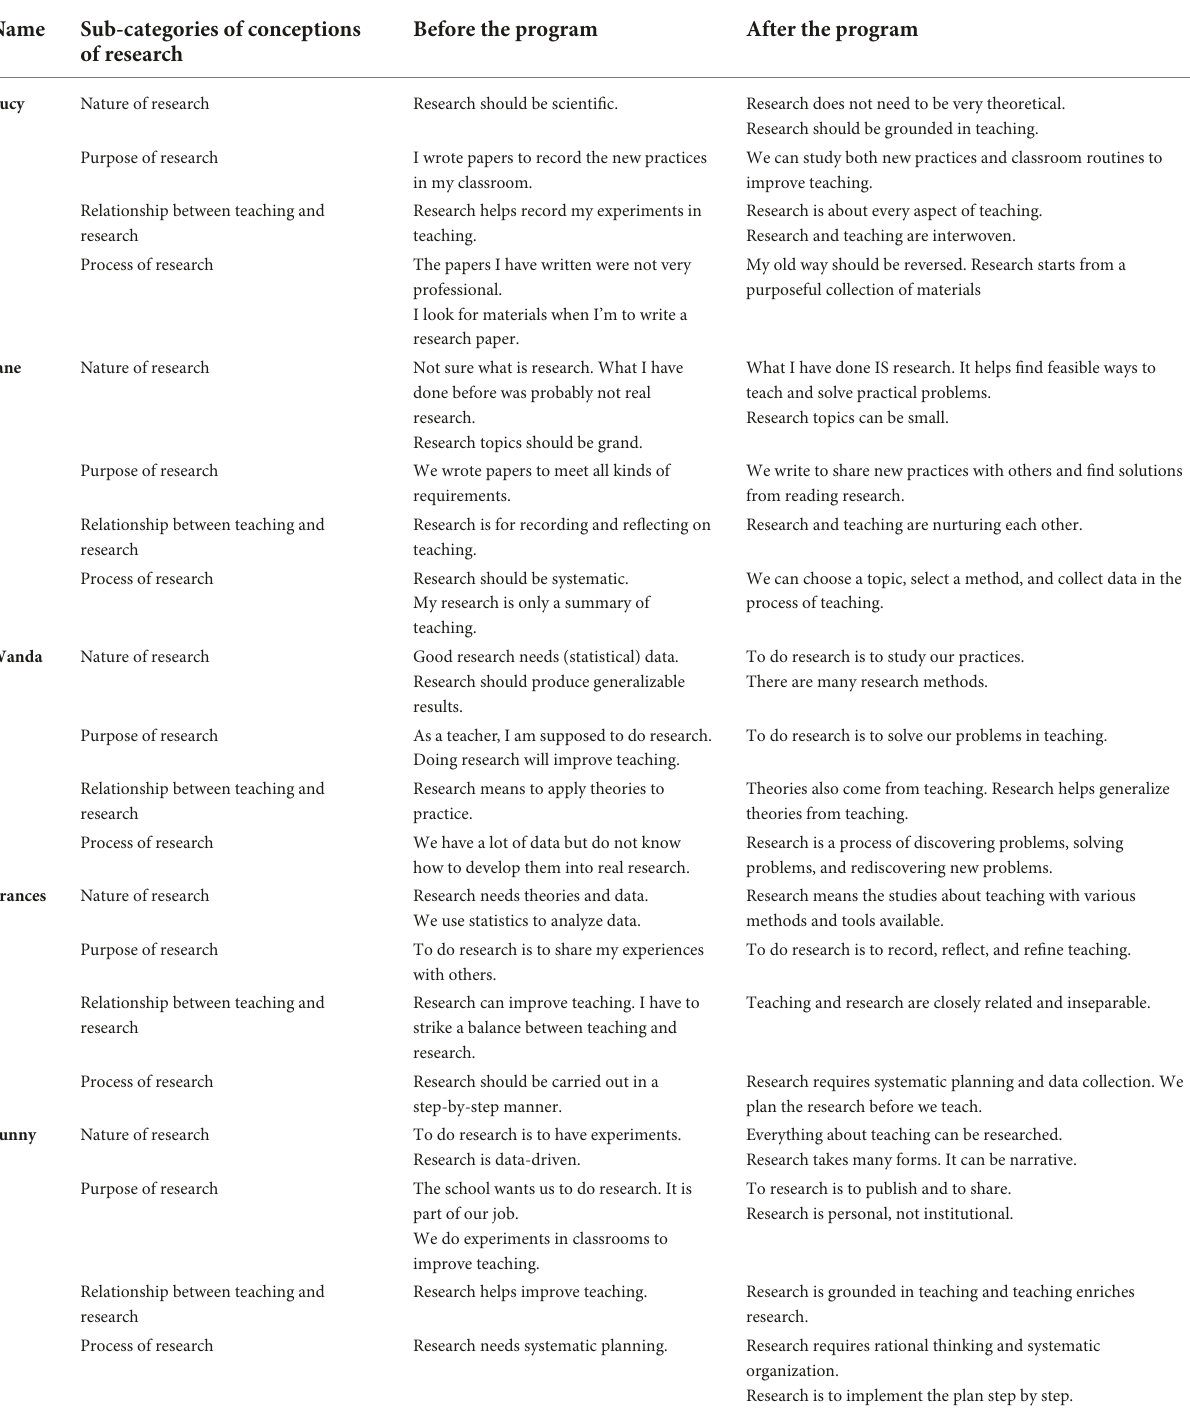
Table 1 Summary of changes in teachers’ conceptions of